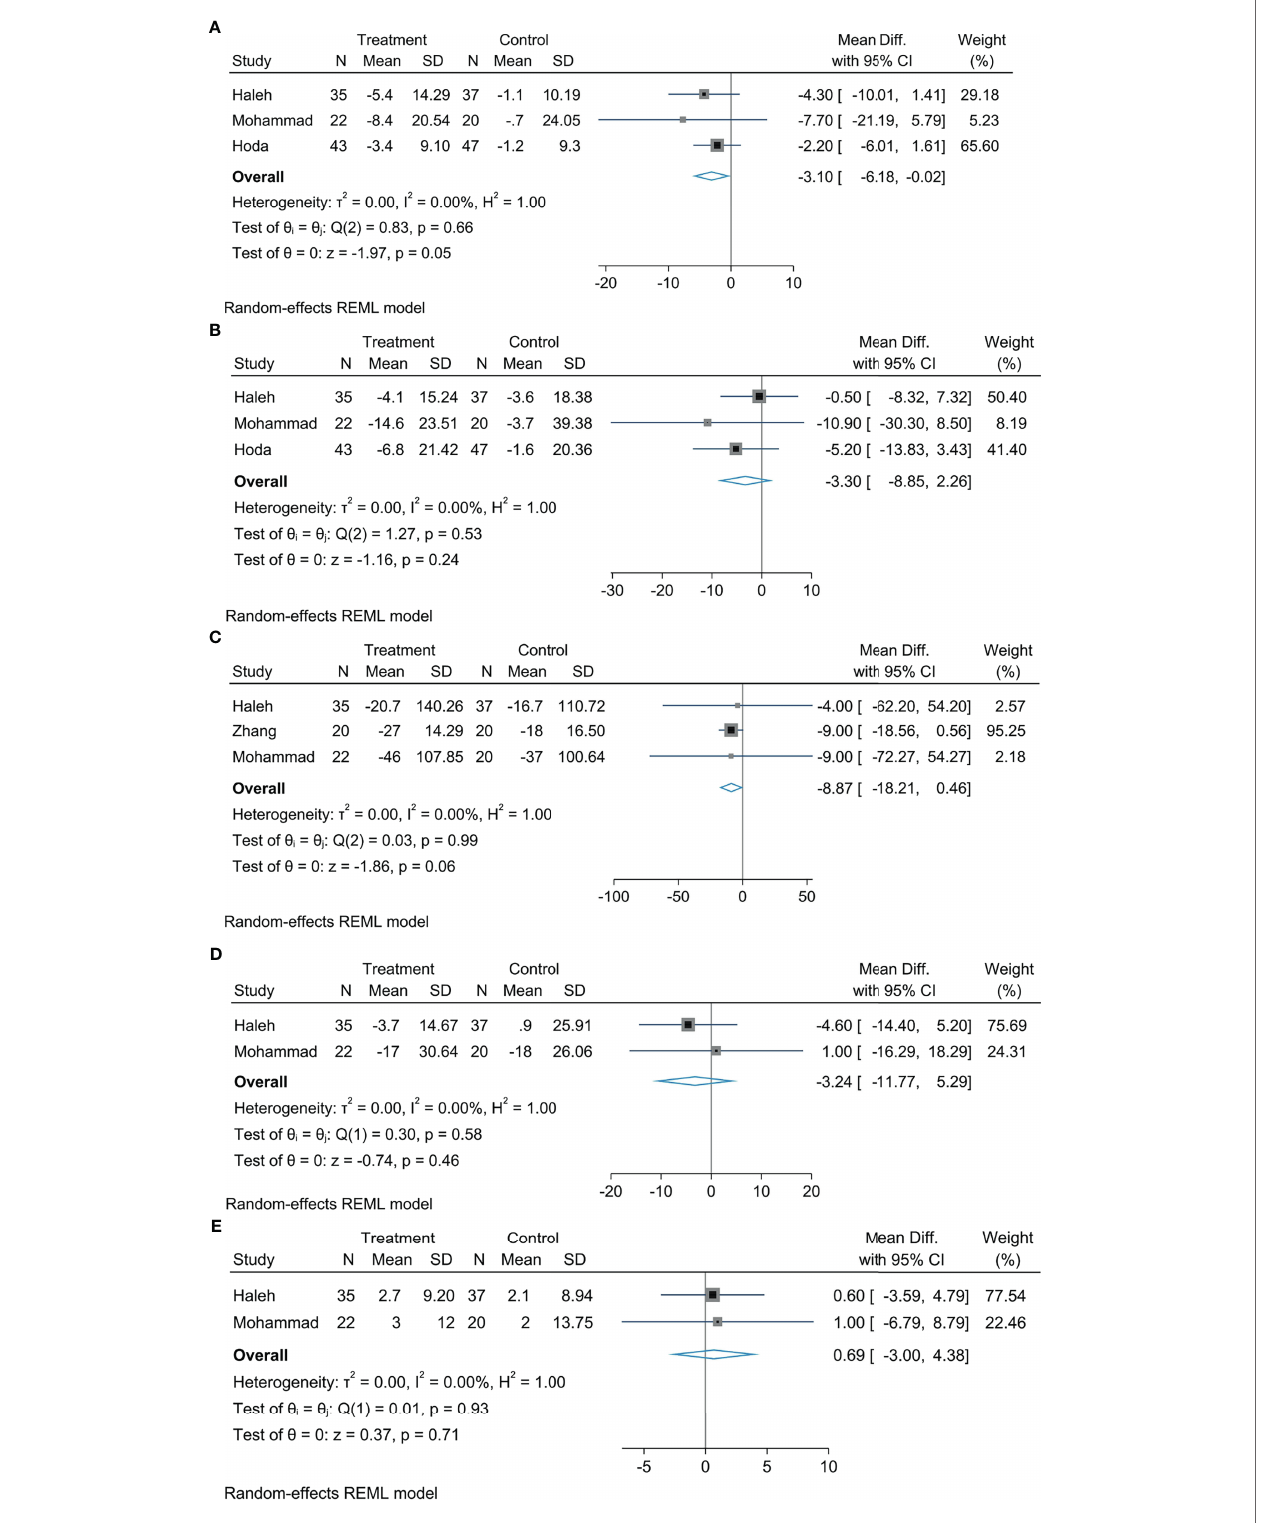
FIGURE 3 | The effect of empagli fl ozin on AST (A) ; the effect of empagli fl ozin on ALT (B) the effect of empagli fl ozin on TG (C) ; the effect of empagli fl ozin on LDL (D) ; the effect of empagli fl ozin on HDL (E)